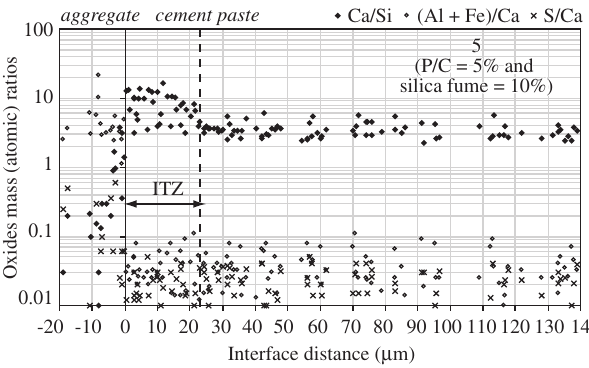
Figure 6. The ratios of Ca/Si, (Al + Fe)/Ca and S/Ca to concrete 5 (P/C = 5% and S/C = 10%).